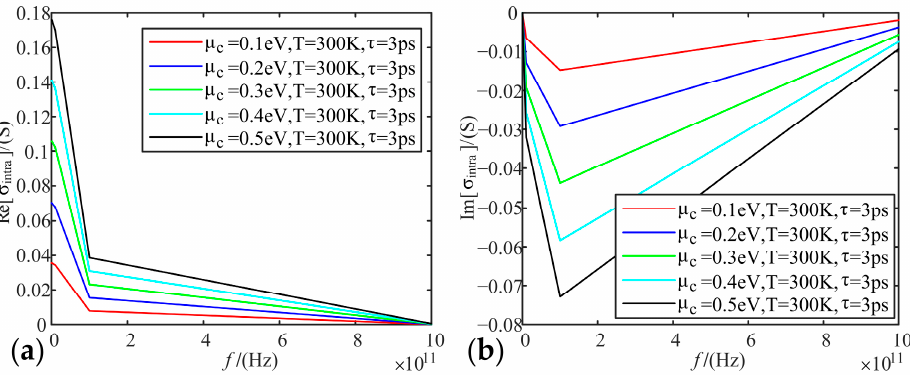
Figure 2. Variation of graphene intra-band conductivity with frequency at different electrochemical potentials: ( a ) real part; ( b ) imaginary part.